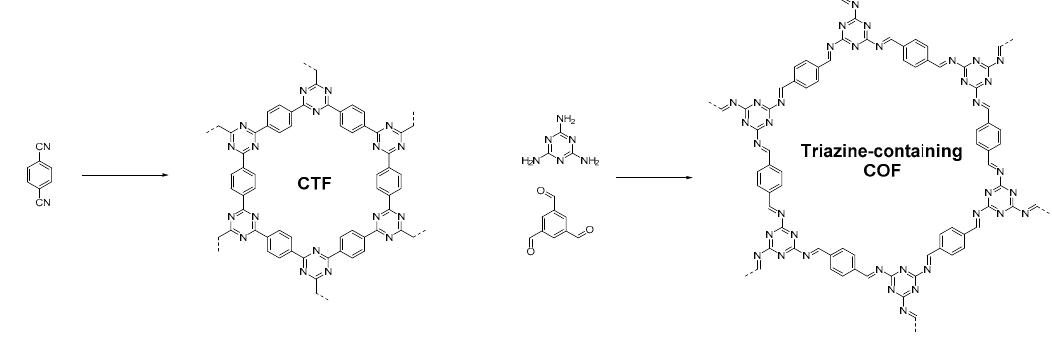
Figure 6. Structural differences between covalent triazine frameworks (CTFs) and triazine ‐ containing COFs.